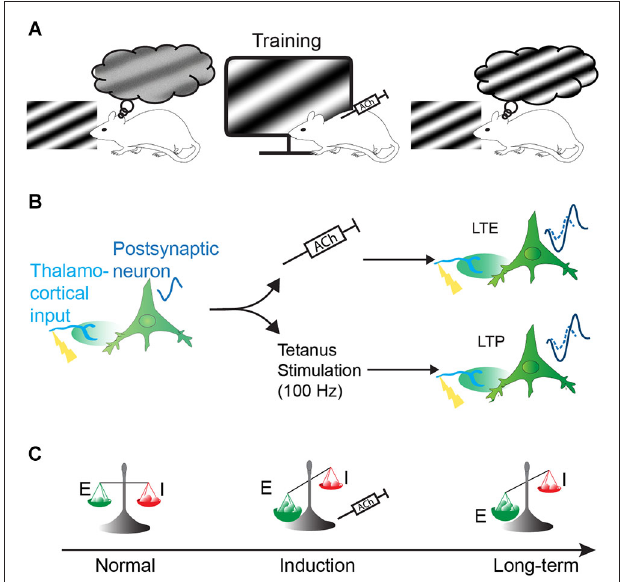
FIGURE 1 | Hypothesis of the effect of the cholinergic system on visual perception . Increase of perceptual capacity (perceptual learning) can be obtained by naturally or artificially activating the cholinergic system during sensory training. This perceptual learning might be achieved by long-term facilitation of cortical responses and/or change of the excitatory/inhibitory balance. (A) Representation of the improvement of visual perception in the rat by pairing the presentation of a specific sinusoidal grating coupled to cholinergic system activation (represented by injection of acetylcholine, ACh). (B) Long-term enhancement (LTE) of the cortical responses by ACh (upper path) share common features with classical long-term potentiation (LTP, lower path): visual stimulation of presynaptic input evokes small responses (represented by a resulting small visual evoked potential (VEP) signal waveform) in post-synaptic neurons. If paired to cholinergic activation, the presynaptic stimulation induces a long-term enhancement of neuronal responses (upper path, represented by an increased VEP signal waveform). This mechanism is similar to LTP where theta-burst stimulation (100 Hz) in lateral geniculate nucleus (LGN) induces an increase of postsynaptic potentiation in the cortex (lower path). VEP signals are imaginary waveform to compare neuronal response magnitude, as recorded in our previous experiments. (C) Cortical plasticity induced by ACh could also result from a change in excitatory and inhibitory balance by changing the strength of the excitatory synapse over inhibitory synapses, resulting in long-term modification of cortical